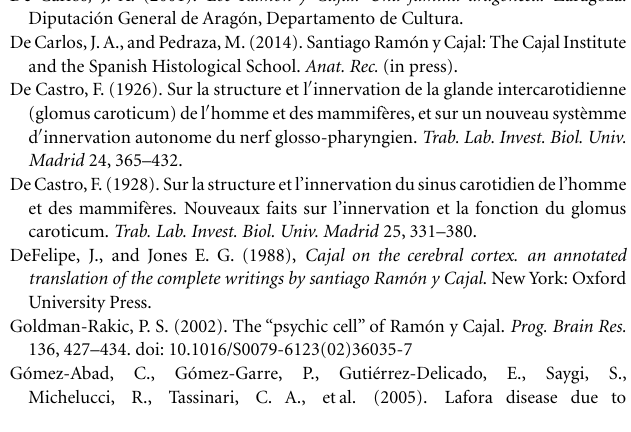
FIGURE 3 | Santiago Ramón y Cajal accurately drew and described the morphological appearance of a breast carcinoma more than 100 years ago. The drawing on the right is adapted from Figure 48 in Ramón y Cajal (1890). The morphology of the cell highlighted as “b” (blue shadow) is believed to be the first description of the